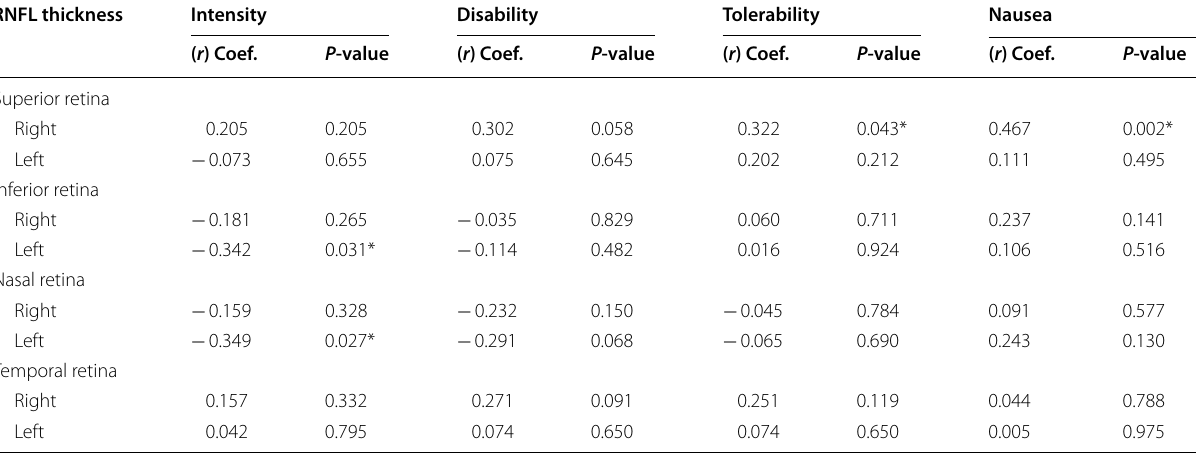
* : significant RNFL retinal nerve fiber layer